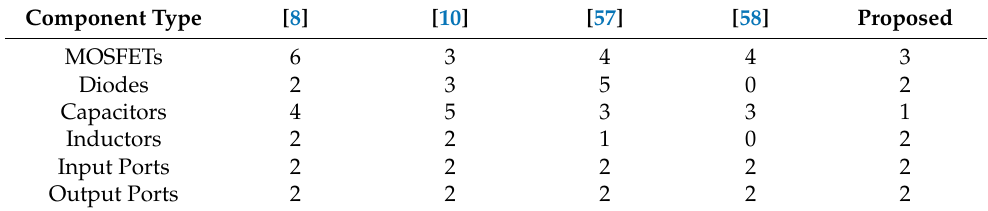
Table 4. Comparison of Components and Output Ports of Various